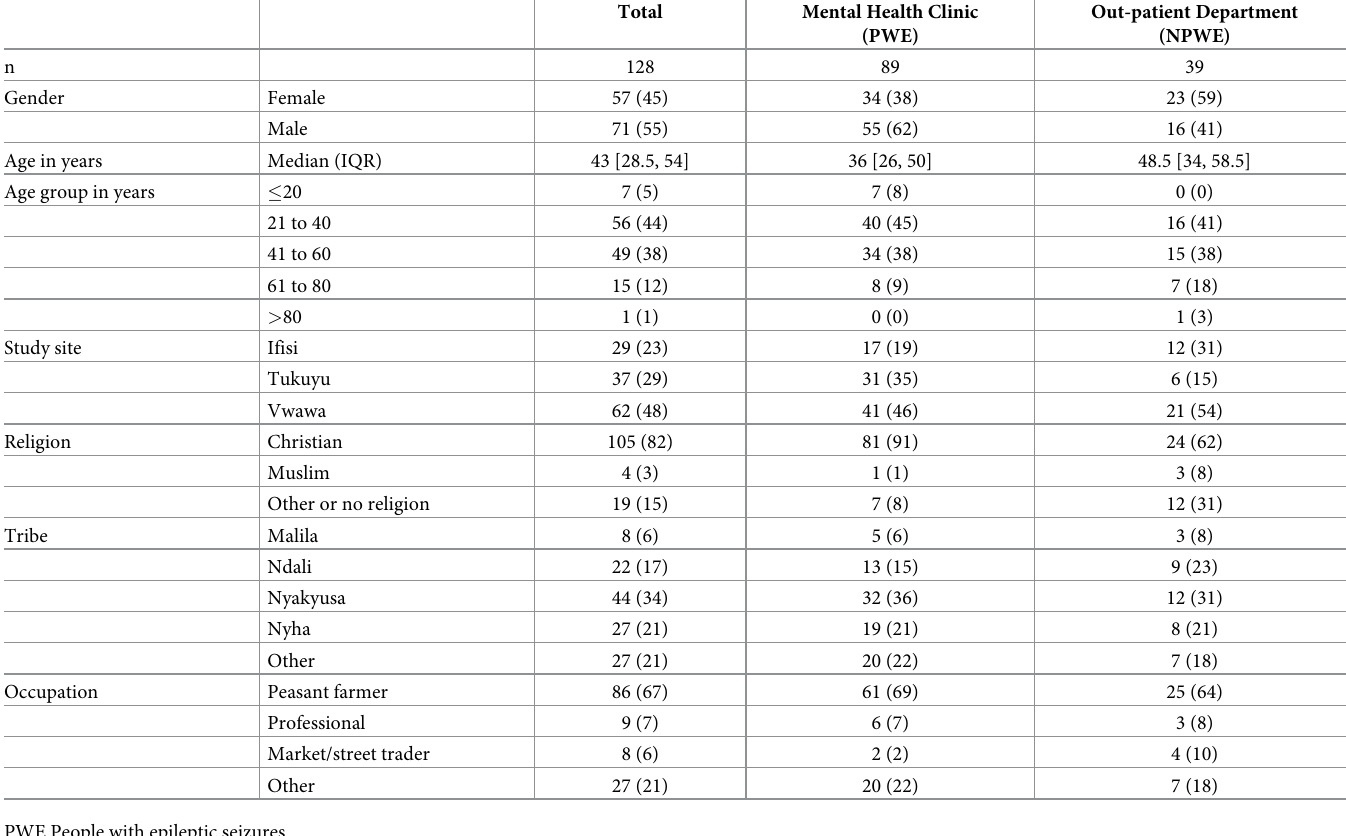
Table 1. Baseline characteristics of people with and without epileptic seizures recruited through the SOLID